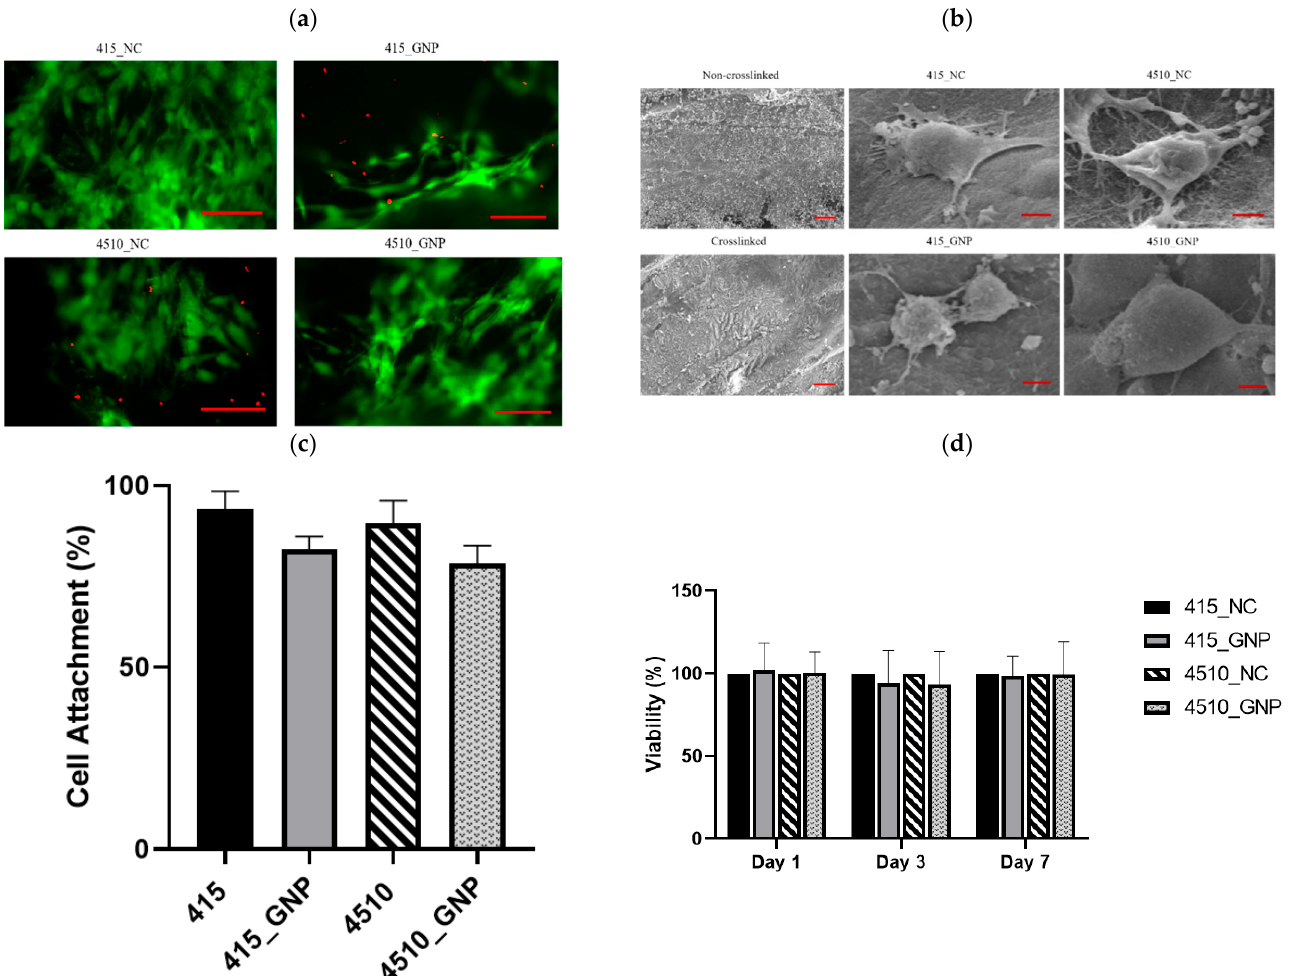
Figure 5. Effect of cross-linking on the cellular biocompatibility of CollaGee biomaterials. ( a ) Live and dead assay, scale bar: 100 µm ( b ) and scanning electron microscope (SEM) analysis, scale bar: 1 µm. The left top and bottom pictures are surface topography without cells, scale bar: 100 µm ( c ) Cell attachment assay revealed more than 80% cell attachments and ( d ) MTT assay revealed no toxicity towards human dermal fibroblasts (HDFs) cultured on cross-linked CollaGee sponges.